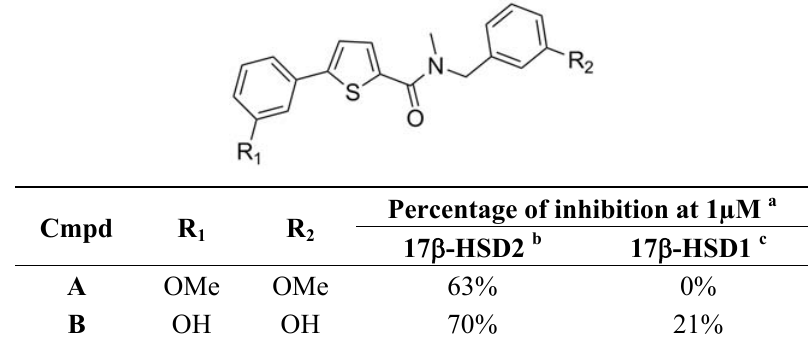
Table 1. In vitro 17  -HSD2 and 17  -HSD1 inhibitory potencies of thiophene-2- carboxamide derivatives A and B